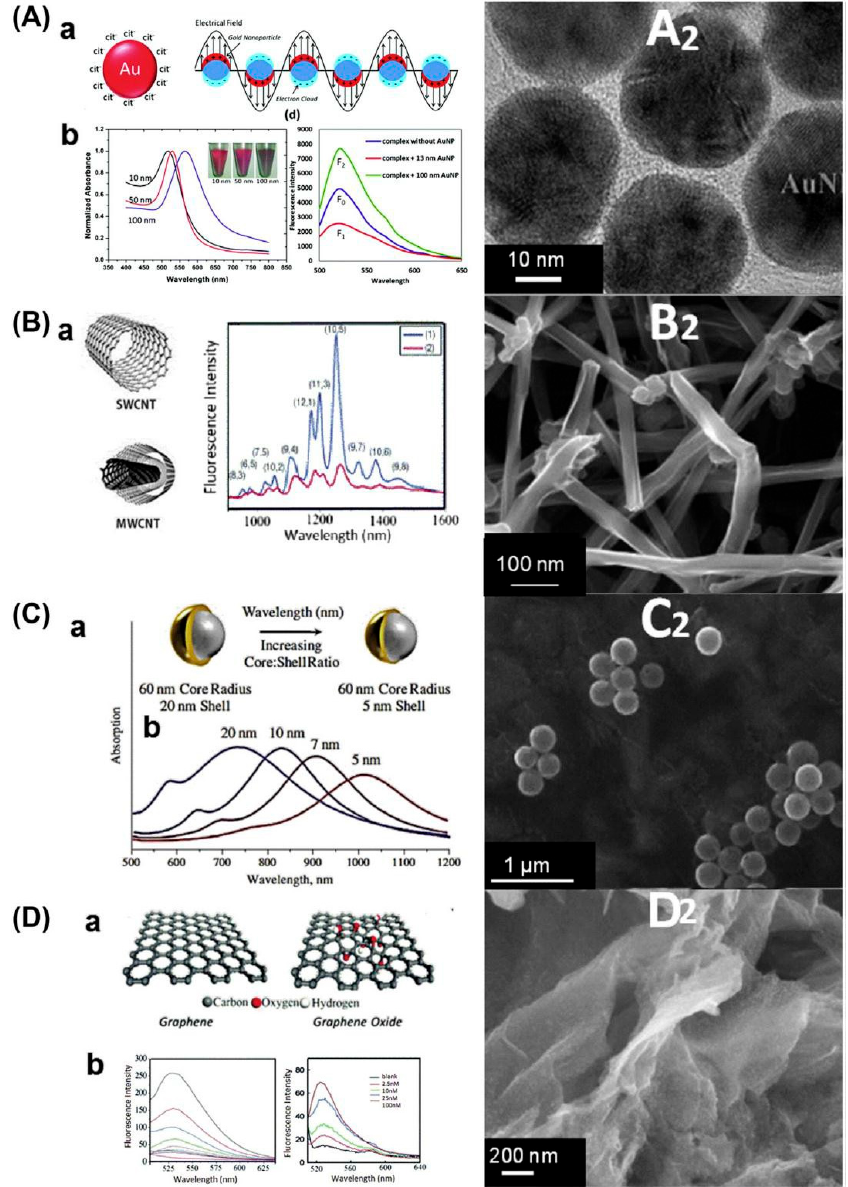
Figure 5. ( A ). Ultra-violet (UV)-Vis absorption spectra corresponding to the gold nanoparticles (AuNPs) of different sizes. ( A2 ) Transmission electron microscopy (TEM) images of synthesized AuNPs with average size of 30 nm. ( B ) Illustration of carbon nanotube (CNT) quenching: fluorescence spectra. ( B2 ). Scanning electron microscopy (SEM) of multiwall CNTs. ( C ) Optical resonances of gold shell-silica core nanoshells as a function of their core/shell ratio. ( C2 ) SEM images of nanoshells. ( D ) Illustration of graphene oxide quenching: fluorescence spectra of graphene and fluorescence spectra of graphene oxide. ( D2 ) SEM image of graphene oxide [29].